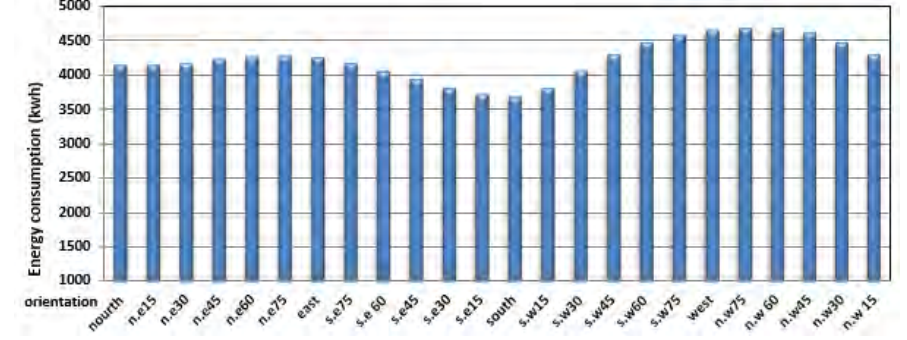
Figure 5. Total energy consumption per year in different